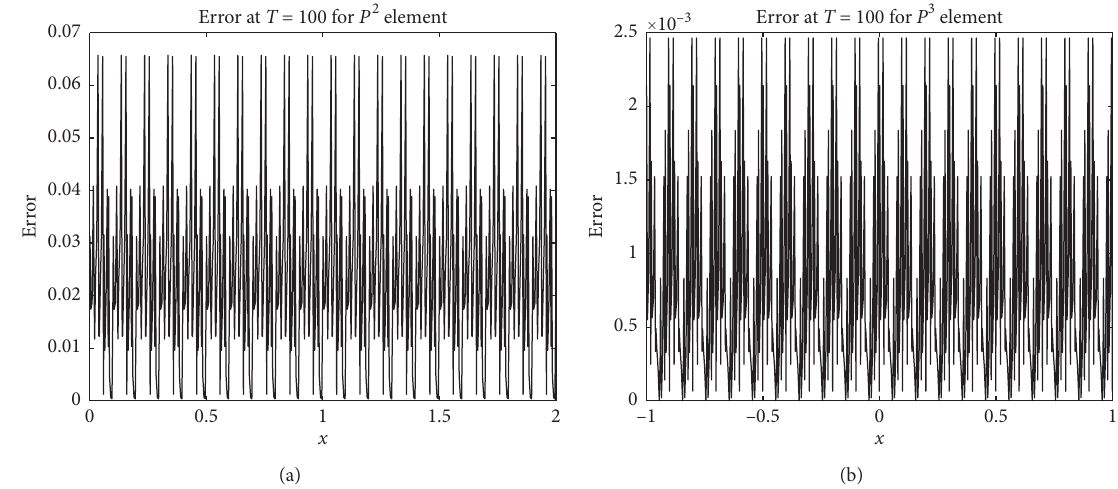
Figure 3: The error ‖ w ( x, t ) − w